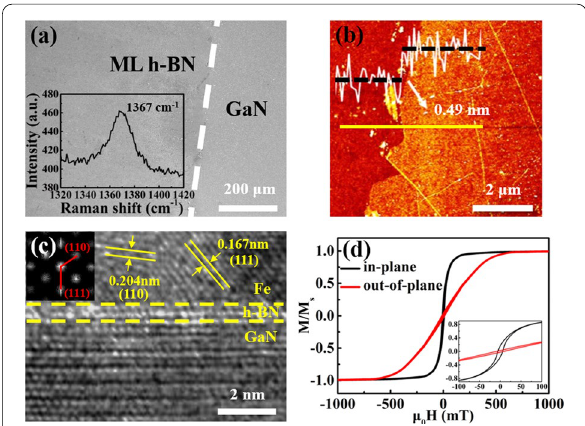
Fig. 1 ( a ) Optical micrograph of monolayer h-BN (denoted as ML h-BN in the figure) transferred on GaN (Inset: Raman spectrum of monolayer h-BN grown on copper foil); ( b ) AFM image and corresponding height profile of monolayer h-BN; ( c ) Cross-sectional TEM image of the Fe/h-BN/GaN spin injection structure (Inset: FFT image of the Fe region); ( d ) In-plane and out-of-plane hysteresis loops of the Fe film grown on h-BN/GaN (Inset: partial enlarged hysteresis loops near the zero point)